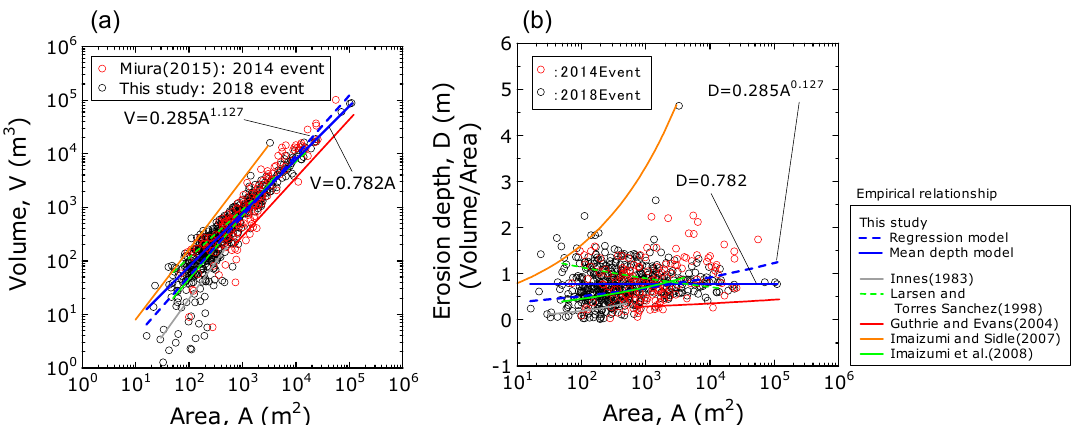
Figure 6. ( a ) Relationship between landslide area and volume of debris flow events. The relationships of the 2014 and 2018 events are derived from the LiDAR data analysis in Miura [5] and this study, respectively. ( b ) Relationship between erosion area and erosion depth derived from LiDAR data analysis in the 2014 and 2018 events. Empirical relationships derived in the previous debris flow studies are illustrated by colored lines. Empirical relationships derived from regression analysis and mean depth of the 2014 and 2018 events are plotted as blue dotted and solid lines, respectively. Table 2. Empirical relationships linking area to volume obtained in this study and the previous